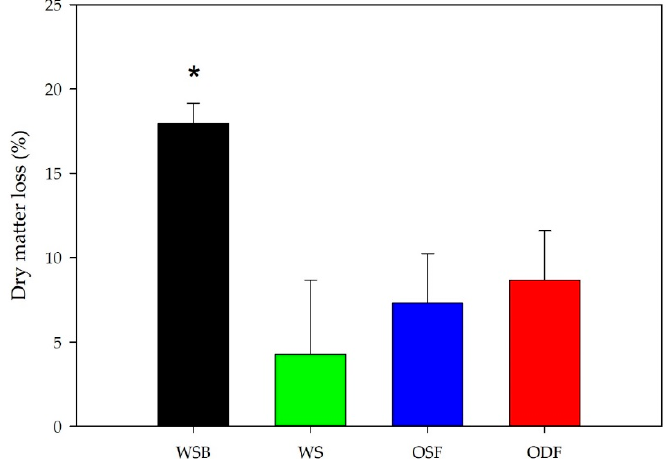
Figure 6. Dry matter loss for each storage method. WS is the outdoor storage of whole stems without branches; WSB is the outdoor storage of whole stems with Branches; OSF is the open shed storage of firewood logs in mesh bags; ODF is outdoor firewood logs in mesh bags (ODF). Differences between the storage method in sampling date are indicated with * ( p -value < 0.05). Bar error represents standard deviation.